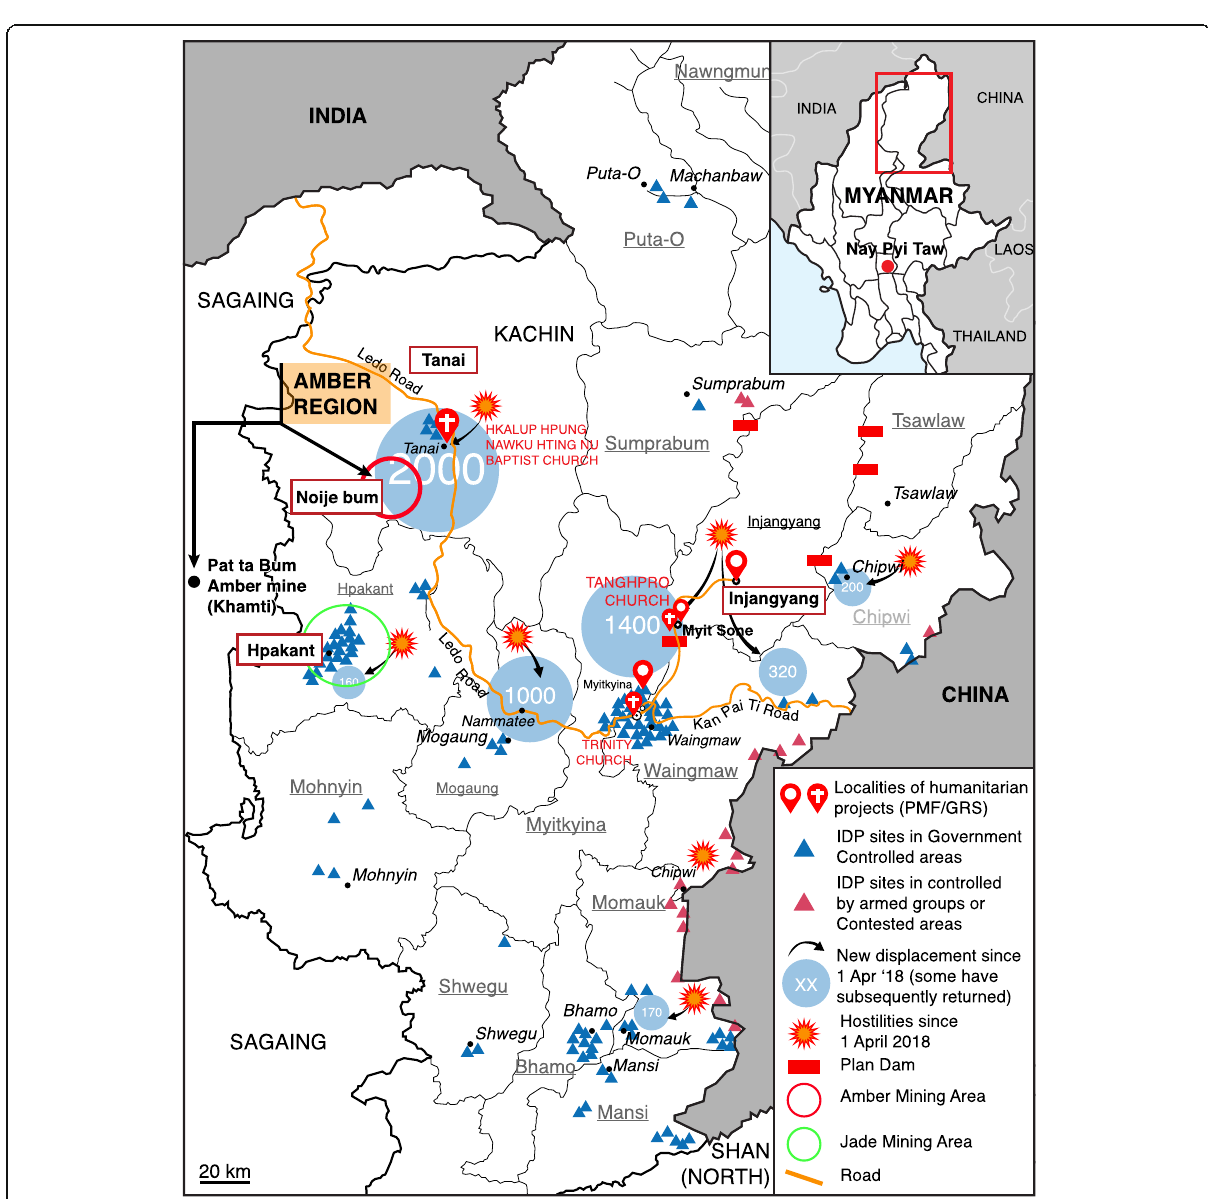
Fig. 1 Map of the North of Myanmar, modified from Ji (2019) to indicate of different mining districts, conflict areas, internally displaced person camps (IDP), and areas with humanitarian projects. These projects were initiated in the year 2018 by the author in cooperation with the Trinity Baptist Church outside of Myitkyina, the Myitsone RC Church and the Baptist Church near Tanai for people fleeing from Injangyang township, and the amber mining area (Peretti, 2020). These are the areas with detailed insider information available to the author. Red squares indicate conflict locations mentioned in a UNHRC Report (United Nations Human Rights Council.